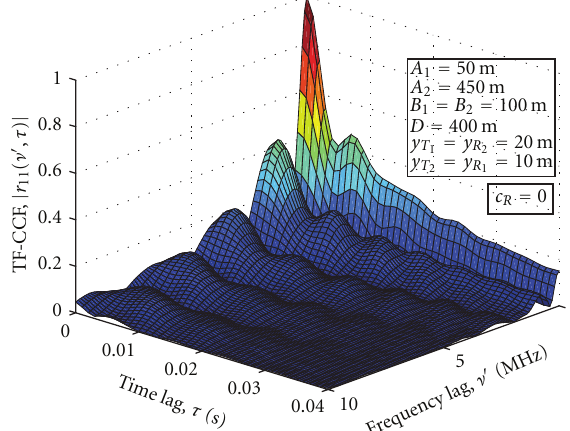
Figure 5: Absolute value of the TF-CCF | r 11 ( ν (cid:4) , τ ) | of the reference model for a NLOS propagation scenario ( c R = 0).